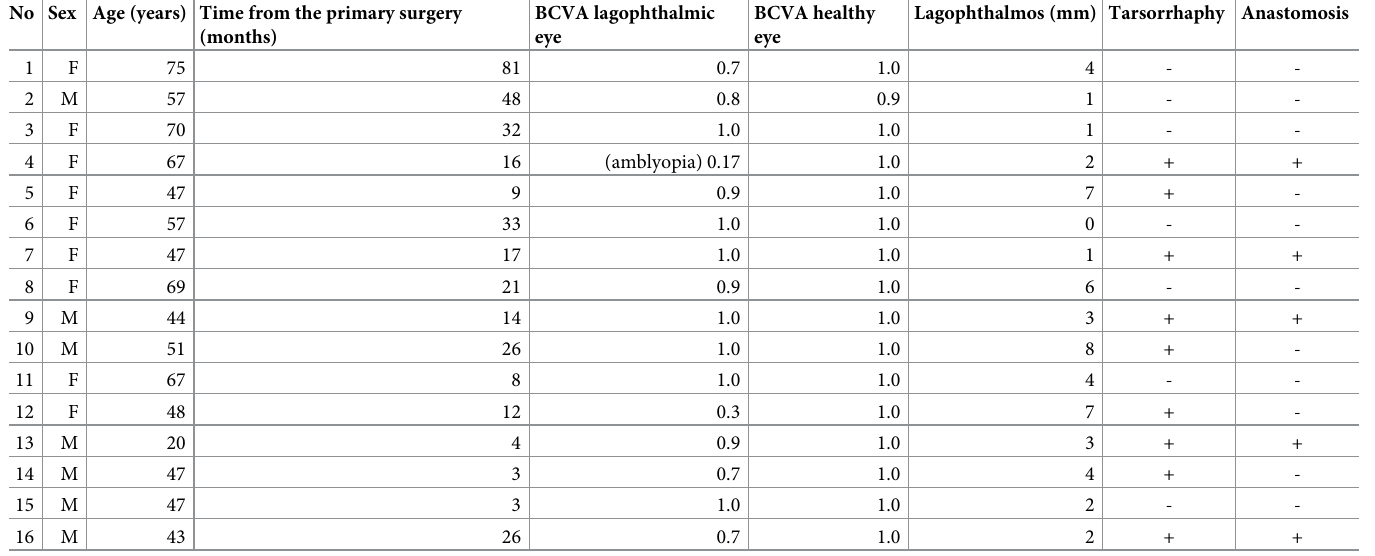
Table 1. Cohort characteristics.